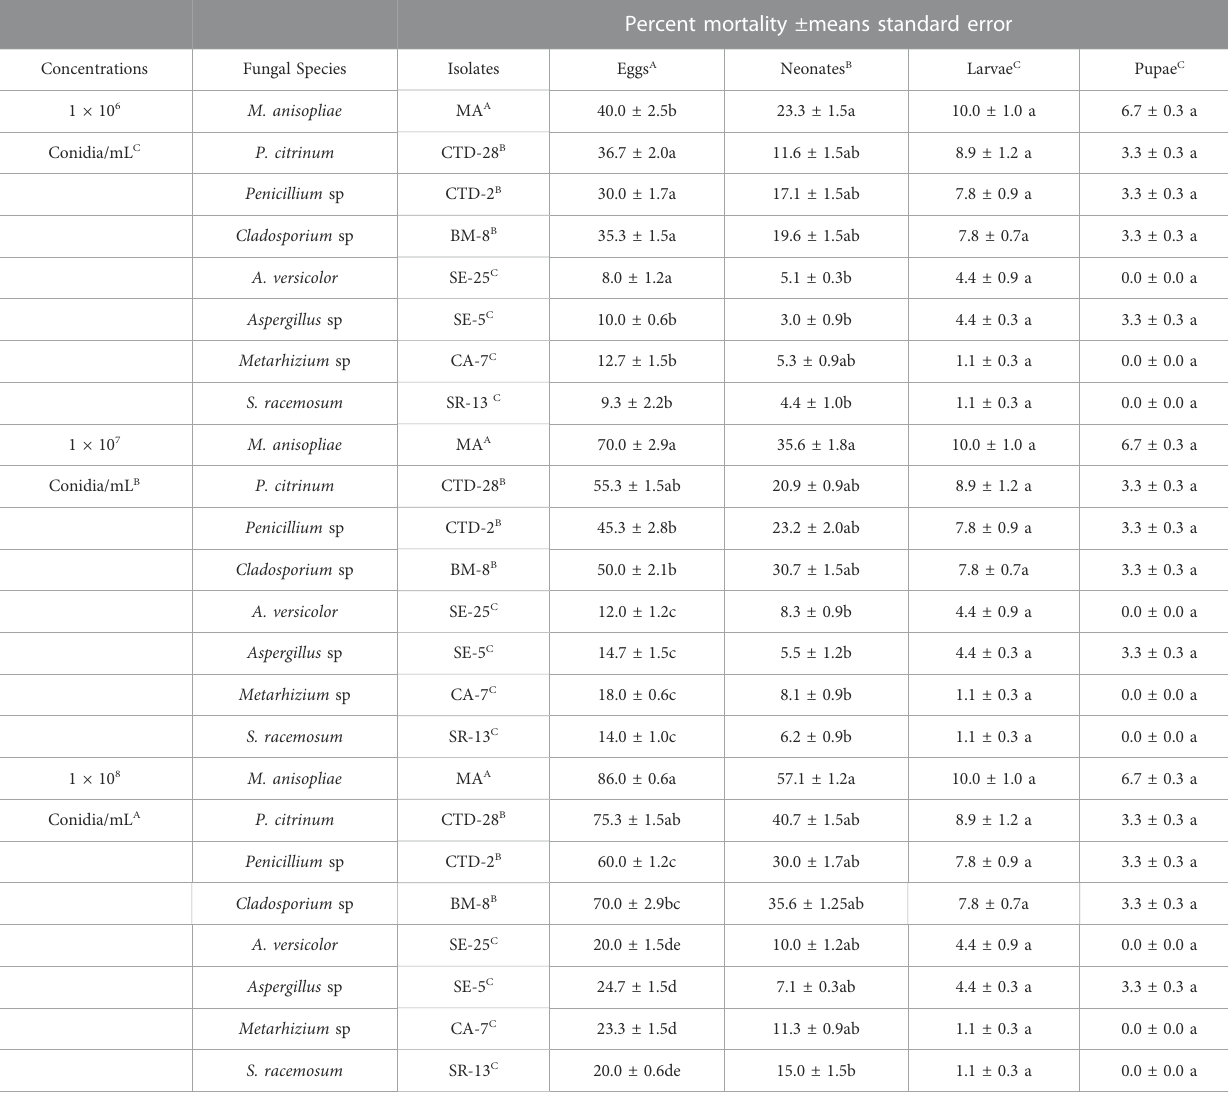
TABLE 2 Mortality (Means ± SEs) of immature stages of fall armyworm treated with different concentrations of isolates of entomopathogenic